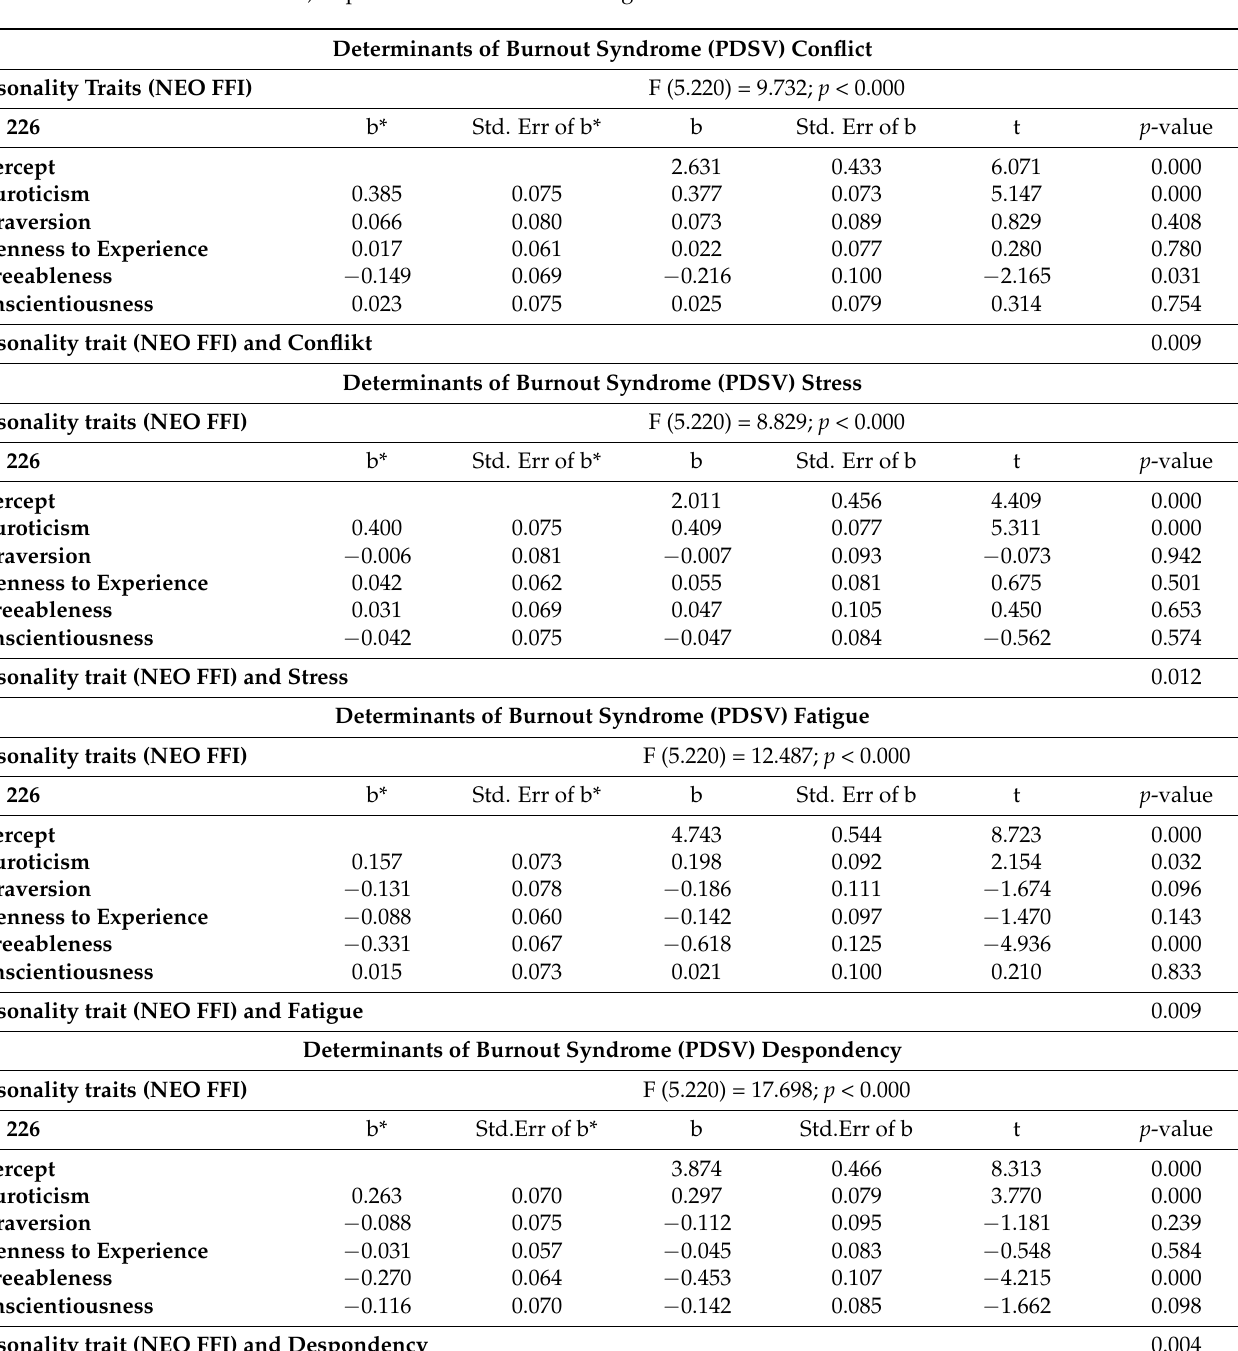
Table 5. Regression between determinants of burnout syndrome (PDSV) and personality traits (NEO FFI) of public administration